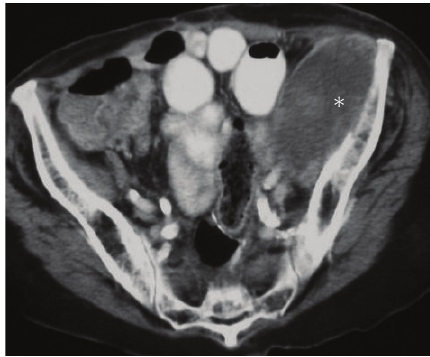
Figure 10: Post-radiation sarcoma. A 78-year-old female presenting with left upper thigh and hip pain. The patient had received radio- therapy to the pelvis 32 years previously, for an ovarian malignancy, and was later diagnosed with radiation-induced sarcoma. Axial contrast-enhanced CT identifies a large, heterogeneously enhancing mass along the inner surface of the left ilium (asterisk) with local bone destruction of the inner cortex.